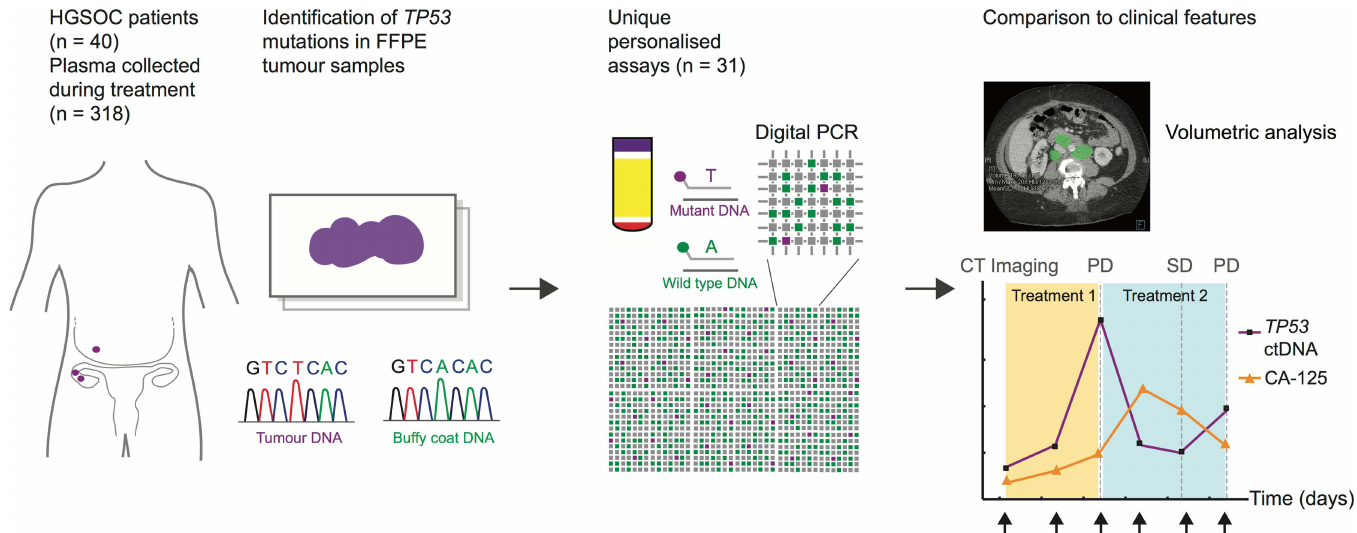
Fig 1. Schema of workflow for circulating tumour DNA analysis. ctDNA, circulating tumour DNA; FFPE, formalin-fixed paraffin-embedded;HGSOC, high-grade serous ovariancarcinoma;PD, progressive disease;SD, stable